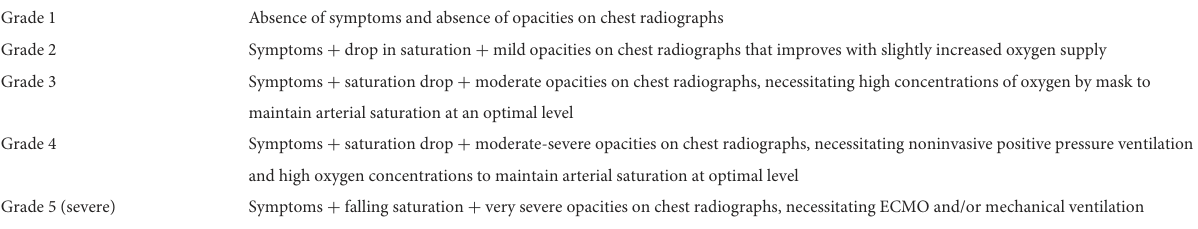
TABLE 1 Reperfusion edema (or pulmonary injury) classification.